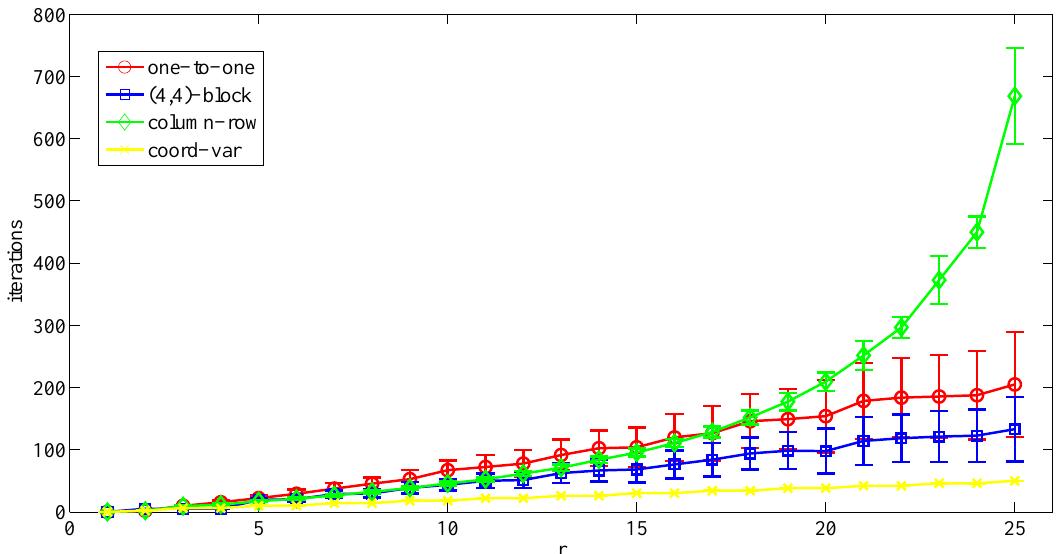
Figure 12. Average number of meetings ( ± its standard deviation) required to converge to the specified area partition strategy considering a r × r configuration and depending on the number of UAVs and different coordination